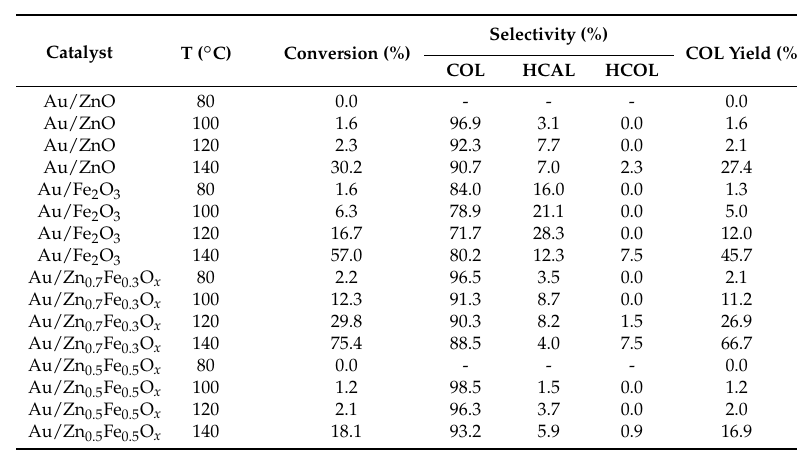
Table 6. Effect of reaction temperature on the catalytic performance of the supported gold nanocatalysts in the selective hydrogenation of